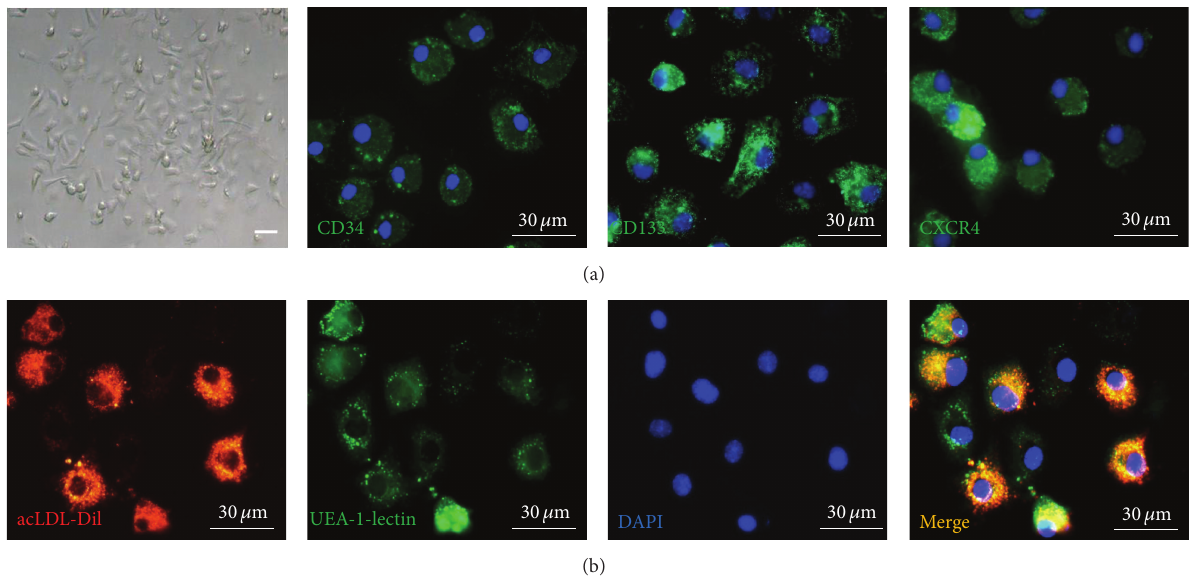
Figure 2: Morphological changes and immunocytochemical analysis in mouse bone marrow-derived EPCs. (a) MNCs changed from globe- like shape to being thin and flat and then round and fusiform at day 7 (bar = 30 𝜇 m). These cells were positive by indirect immunofluorescent staining for the markers of hematopoietic stem cells and progenitor cells, CD34, CD133, and CXCR4 (bar = 30 𝜇 m). (b) The EPCs were able to take up Dil-labeled acetylated low-density lipoprotein (LDL) and bind the endothelial-specific lectin FITC-labeled lectin after 14 days in culture, which were colocalized in > 95% cell (bar = 30 𝜇